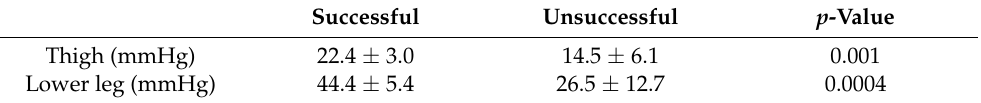
Table 3. Compression pressures applied according to whether liposuction was successful or